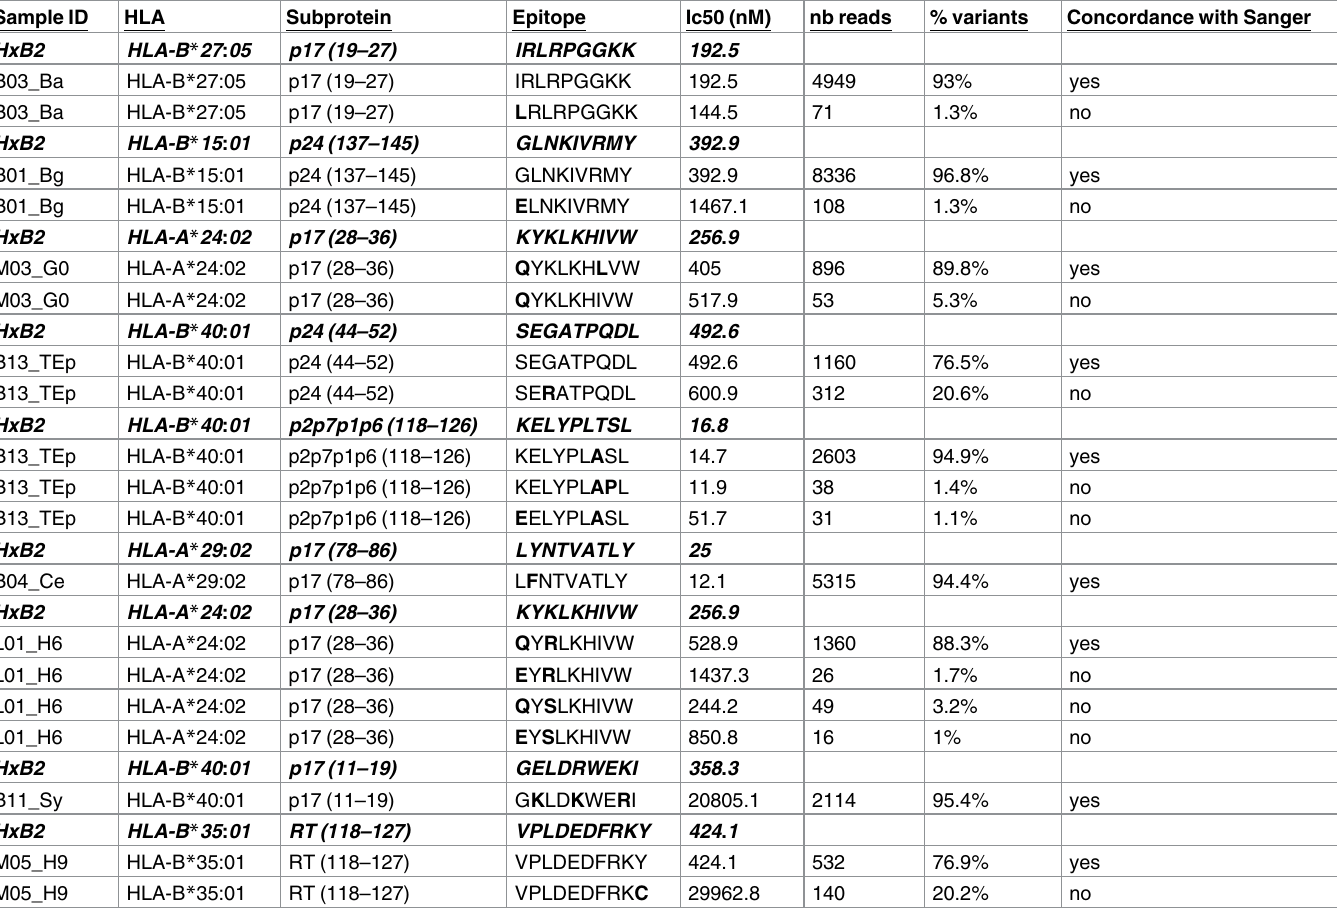
Table 2. Output of TutuGenetics and comparison with Sanger sequencing results: Eight HLA/peptide associations are detailed. For each sample and HLA, the first line shows the putative epitopedescribedin the HxB2 reference sequenceand the calculatedIC50 (nM). For each epitope, the numberof NGS reads as wellas the percentage of variantsis alsoshown.The mutatedamino-acids are in bold.In the last column,“yes” meansthat this epitopeobtained with NGS was retrieved in the Sanger sequence;“no” indicatesthat the epitopecan be quantified by NGS but was not observed by Sanger. Sample